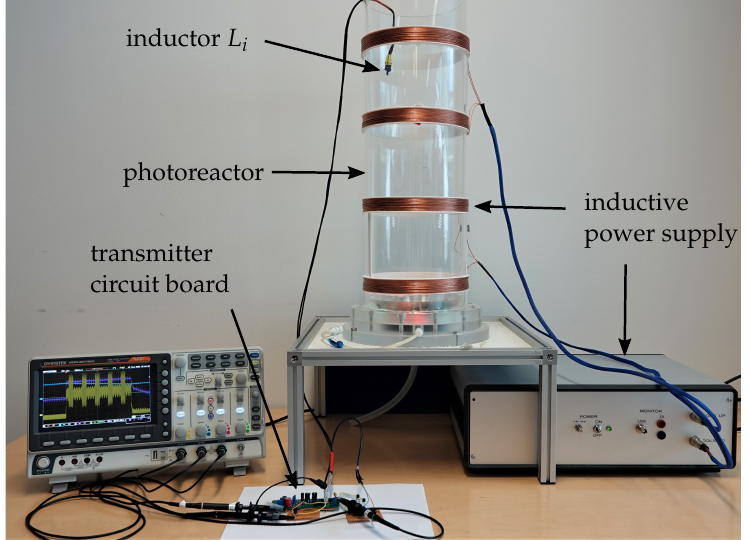
Figure 16. Laboratory setup where only the WPT/data transmitting coil is placed inside the photore- actor. The circuit board with the remaining components is placed in front of the reactor. On the left side, the oscilloscope depicts the measured